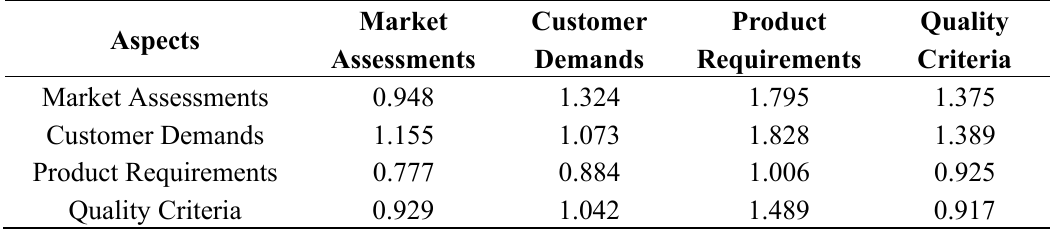
Table 4. Total-Relation Matrix (T) for Aspects.